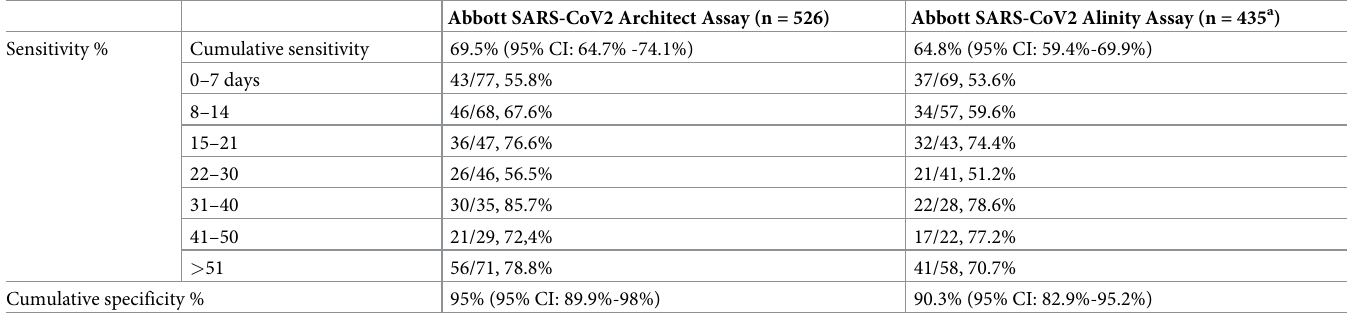
Table 3. Sensitivity of each assay compared with RT-qPCR.